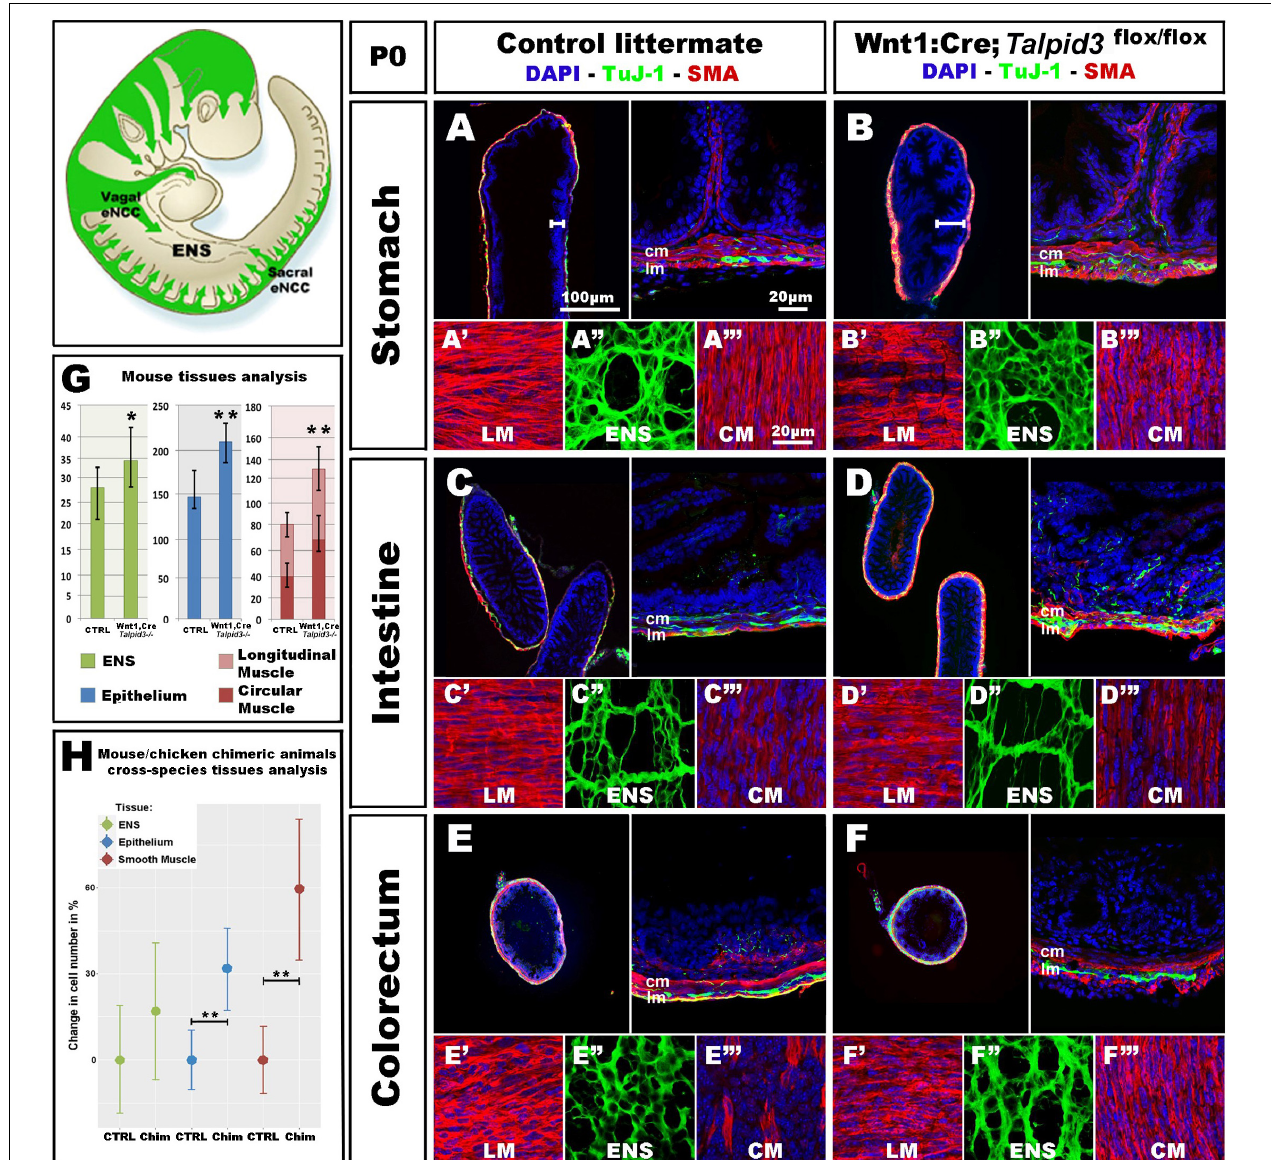
FIGURE 6 | Wnt1:Cre;Talpid3 flox / flox mice show grossly normal ENS but smooth muscle and epithelium defects. (A–F) Immunofluorescent staining for TuJ-1 and SMA at the level of (A,B) the stomach, (C,D) intestine and (E,F) colorectum in control littermate and Wnt1:Cre;Talpid3 flox / flox P0 pups, respectively. (A (cid:48) –A (cid:48)(cid:48)(cid:48) ,B (cid:48) –B (cid:48)(cid:48)(cid:48) ,C (cid:48) –C (cid:48)(cid:48)(cid:48) ) confocal projections at the level of the longitudinal muscle (LM), enteric nervous system (ENS) and circular muscle (CM), respectively. (G) Bar graph shows cell counts for ENS, LM, CM and total smooth muscle, as well as epithelium in control littermate versus Wnt1:Cre;Talpid3 flox / flox . In the stomach, the ENS (green) showed a statistically significant (* p = 0.045) increase of 29% in the number of ENCC in the mutant, compared to control. Epithelium (blue) showed a statistically significant (** p = 0.009) increase of 39% in the mutant, compared to control. Muscle layers (red) showed a highly statistically significant (** p = 0.002) increase of 67% in mutant tissue sections compared to control, with 80% increase in the longitudinal muscle (** p = 0.002) and 55% increase in the circular muscle (** p = 0.018). Difference in epithelium thickness is highlighted in (A,B) by white bars. (H) Scatter plot shows mouse/chicken cross-species cell counts for ENS, epithelium and smooth muscle in stomach of controls and chimeric animals. Epithelium (blue) showed a statistically significant (** p = 0.009) increase of 39% in the mutant, compared to control. Muscle layers (red) showed a highly statistically significant (** p = 0.002) increase of 67% in mutant tissue sections compared to control. ctrl, control; chim, chimera; cm, circular muscle; lm, longitudinal muscle. Same scale bars in (A–A (cid:48)(cid:48)(cid:48) –F–F (cid:48)(cid:48)(cid:48) ) .